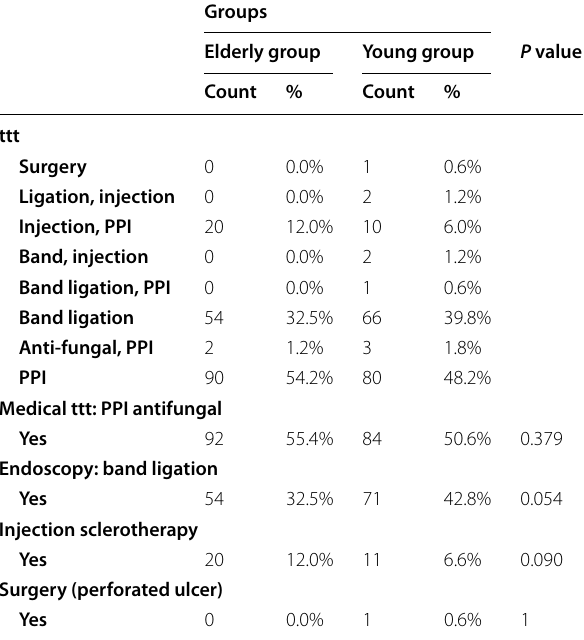
Table 5 Comparison between both groups regarding modality of